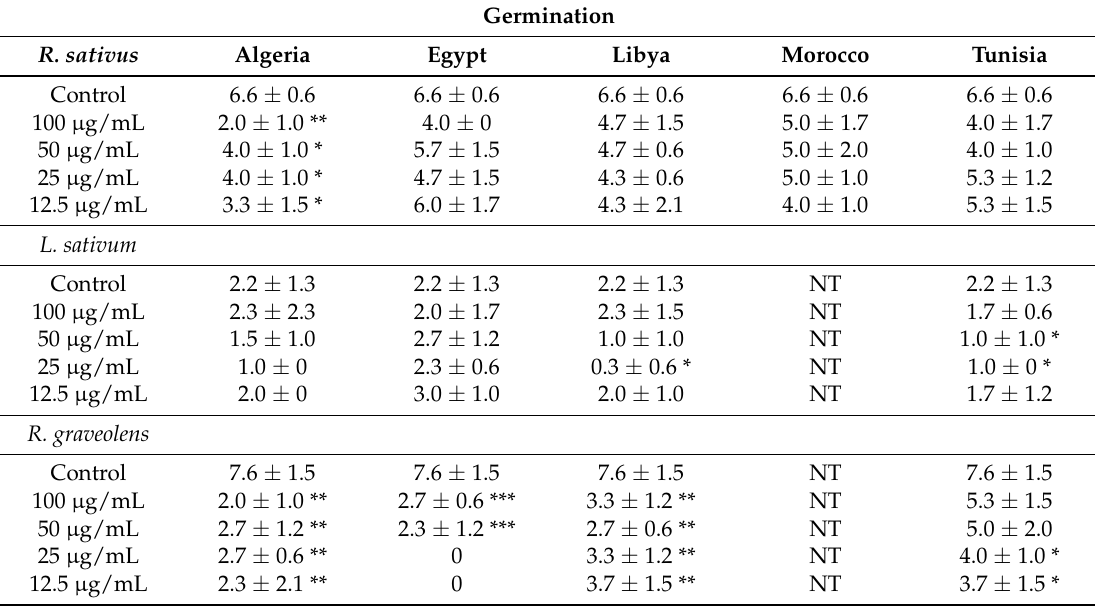
Table 3. Phytotoxic activity of the essential oils of P. harmala from Algeria, Egypt, Libya, Morocco and Tunisia against germination of Raphanus sativus L., Lepidium sativum L., and Ruta graveolens L., 120 h after sowing. Results are expressed as the mean of three experiments ± standard